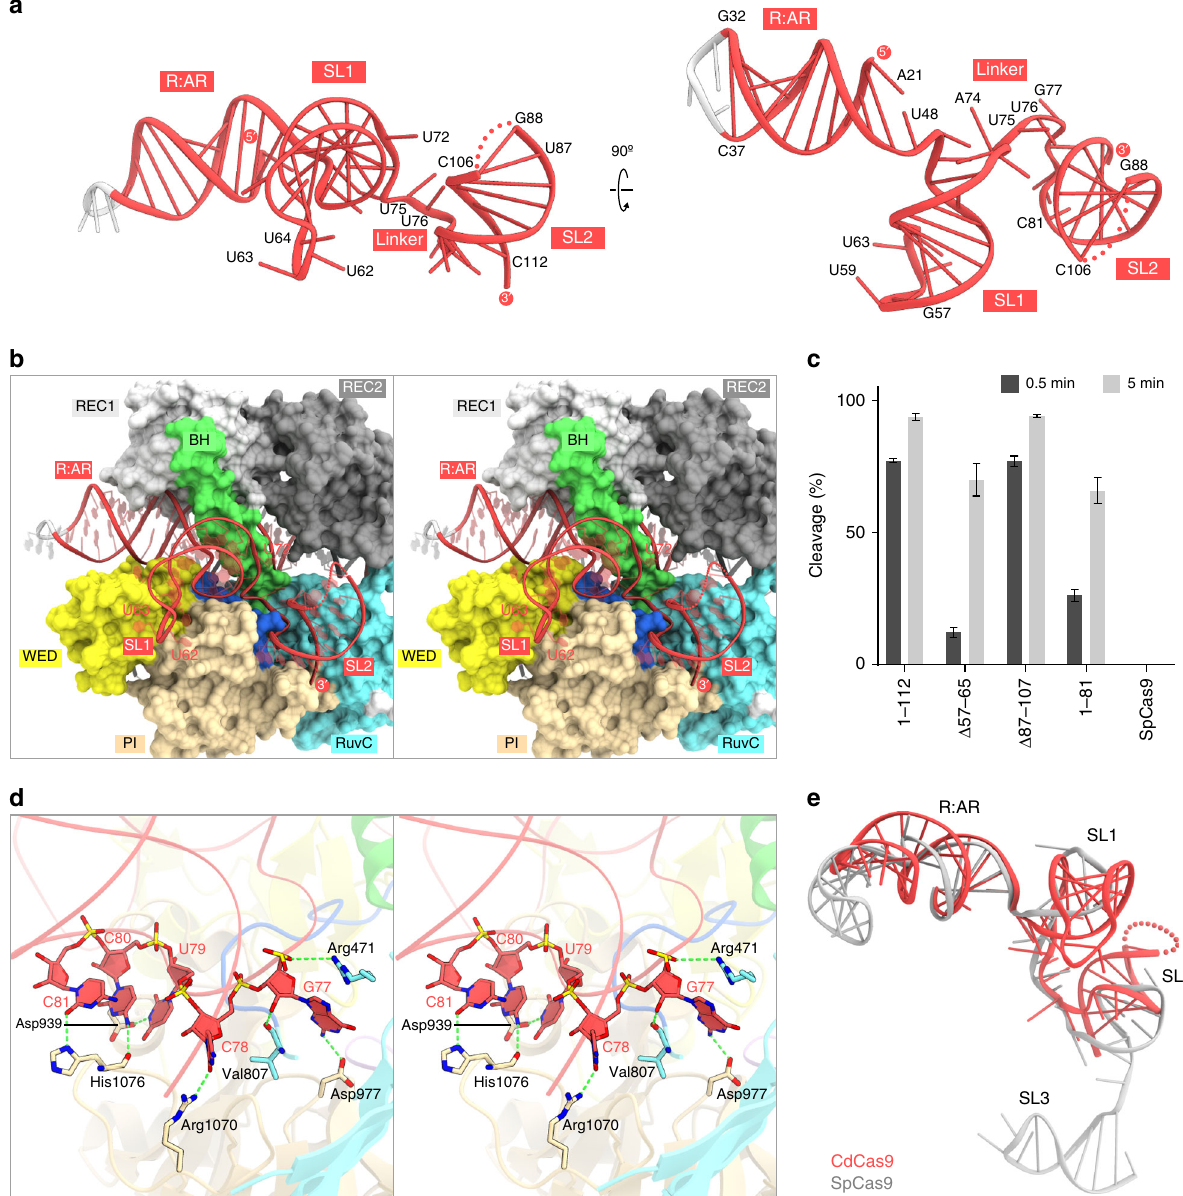
Fig. 5 Structure and recognition of the single-guide RNA (sgRNA) scaffold. a Structure of the sgRNA scaffold. The guide region is omitted for clarity. The disordered region is shown as a dotted line. b Binding of the sgRNA scaffold to Corynebacterium diphtheriae Cas9 (CdCas9) (stereo view). The disordered region of the sgRNA is shown as a dotted line. c Effects of the sgRNA truncation. The linearized plasmid target with the GGGAAAC protospacer adjacent motif (PAM) was incubated at 37 °C for 0.5 and 5 min with CdCas9 and the truncated CdCas9 sgRNA (22-nt guide) or the Streptococcus pyogenes Cas9 (SpCas9) sgRNA (22-nt guide). 1 – 112, the full-length sgRNA; Δ 57 – 65, the sgRNA, in which nucleotides 57 – 65 were replaced with GAAA; Δ 87 – 107, the sgRNA, in which nucleotides 87 – 107 were replaced with GAAA; 1 – 81, the sgRNA, in which nucleotides 82 – 112 were truncated; SpCas9, the SpCas9 sgRNA. d Base-speci fi c recognition of the sgRNA linker region (stereo view). Hydrogen bonds are shown as dashed lines. e Superimposition of the CdCas9 sgRNA and the SpCas9 sgRNA (PDB: 4OO8). The disordered region is shown as a dotted line. Error bars represent s.d. from n = 3 In vitro cleavage assay . The pUC119 plasmid, containing the 24-nt target sequence buffer. The reaction products were resolved on an ethidium bromide-stained 1% agarose gel, and then visualized using an Amersham Imager 600 (GE Healthcare). and the PAMs, was used as the substrate for in vitro cleavage assays (Supplementary Table 6). The Eco RI-linearized pUC119 plasmid (100ng, 4.7nM) was incubated at 37°C for 0.25 – 30min with the CdCas9-sgRNA (50nM) in 10 μ L of reaction buffer, containing 20mM HEPES, pH 7.5, 100mM KCl, 2mM MgCl 2 , 1mM dithiothreitol, and 5% glycerol. The reaction was stopped by the addition of quench buffer, con- taining EDTA (40mM fi nal concentration) and proteinase K (4µg). Reaction pro- tides (Integrated DNA Technologies), containing seven randomized nucleotides ducts were resolved, visualized, and quanti fi ed with a MultiNA microchip downstream of a 20-nt target sequence, were converted to dsDNA via fi ll-in with the electrophoresis device (Shimadzu). For the measurement of the cleavage activity of the large Klenow fragment (New England Biolabs) and cloned into pUC19 by Gibson CdCas9 D10A mutant, the circular pUC119 target plasmid (500ng, 4.7nM) was cloning (New England Biolabs) to generate a library. The plasmid library was digested incubated at 37°C for 0.5 – 5min with the CdCas9-sgRNA (50nM), in 50 μ L of the in vitro with puri fi ed CdCas9 complexed with an sgRNA targeting the PAM library. reaction buffer, and the reaction was then stopped by the addition of the quench The cleavage products were resolved on 2% agarose E-gels (Life Technologies), and